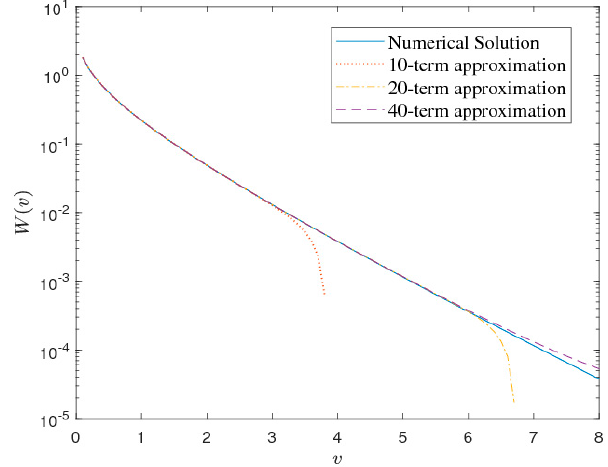
Figure 2. Comparison between numerical solution and 10, 20, and 40 terms of the series Equation (35) for 𝑊(𝑣) .